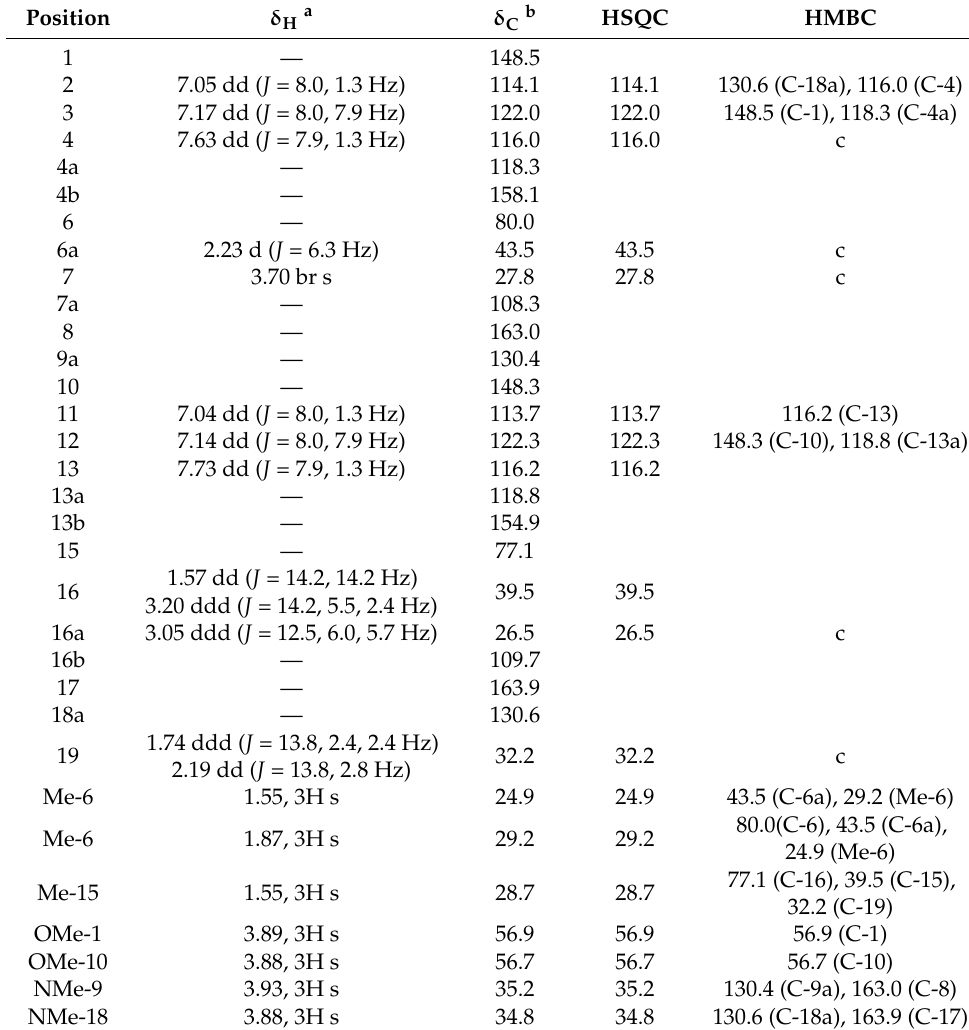
Table 1. NMR spectral data (400 MHz, CDCl 3 ) for compound 1 .